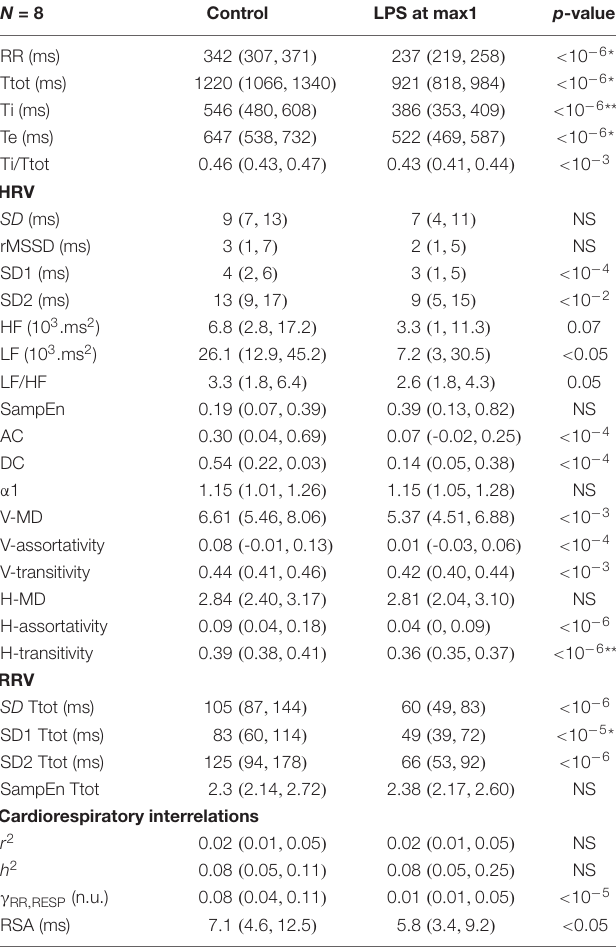
TABLE 2 | Heart-rate and respiratory-rate variability observed in stationary